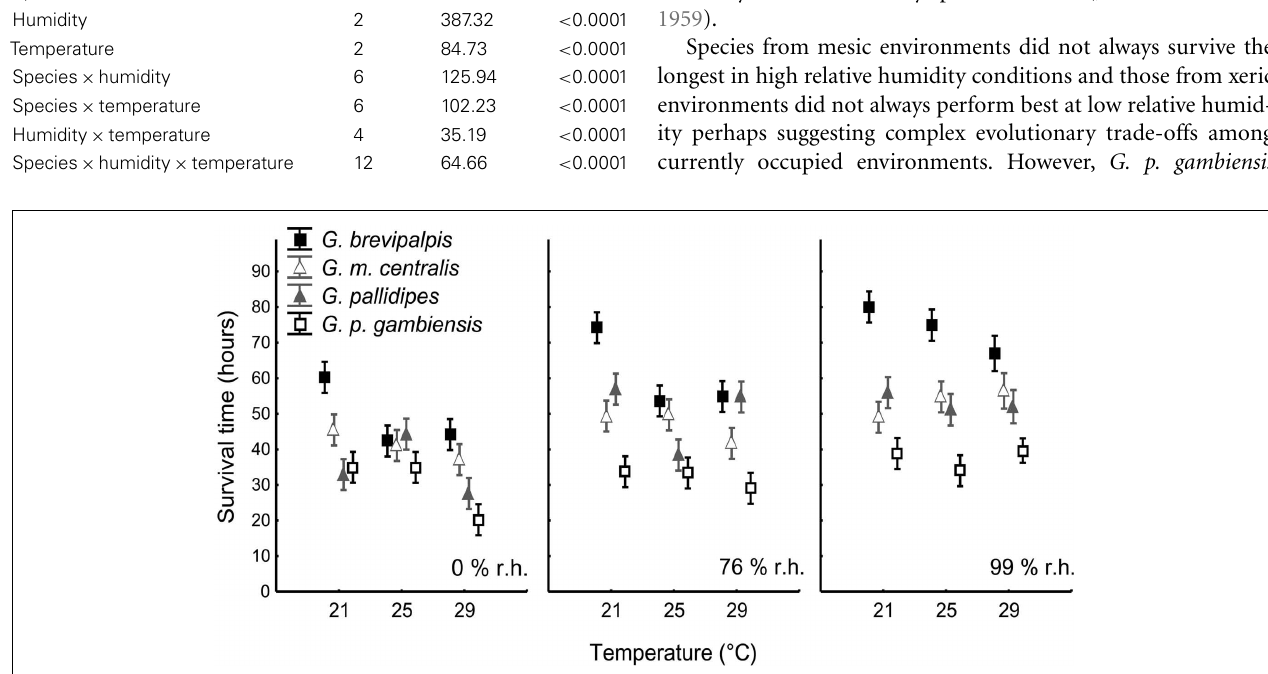
calculated as the sum of the metabolic water yield from lipids (in mg), given the critical lipid mass (see Materials and Methods for details) and the initial body water content (in mg; see Materials and Methods for details), given the critical body water content of each species.This is divided by the rate of water loss (in mg H 2 O/h) under resting conditions. All symbols are offset for